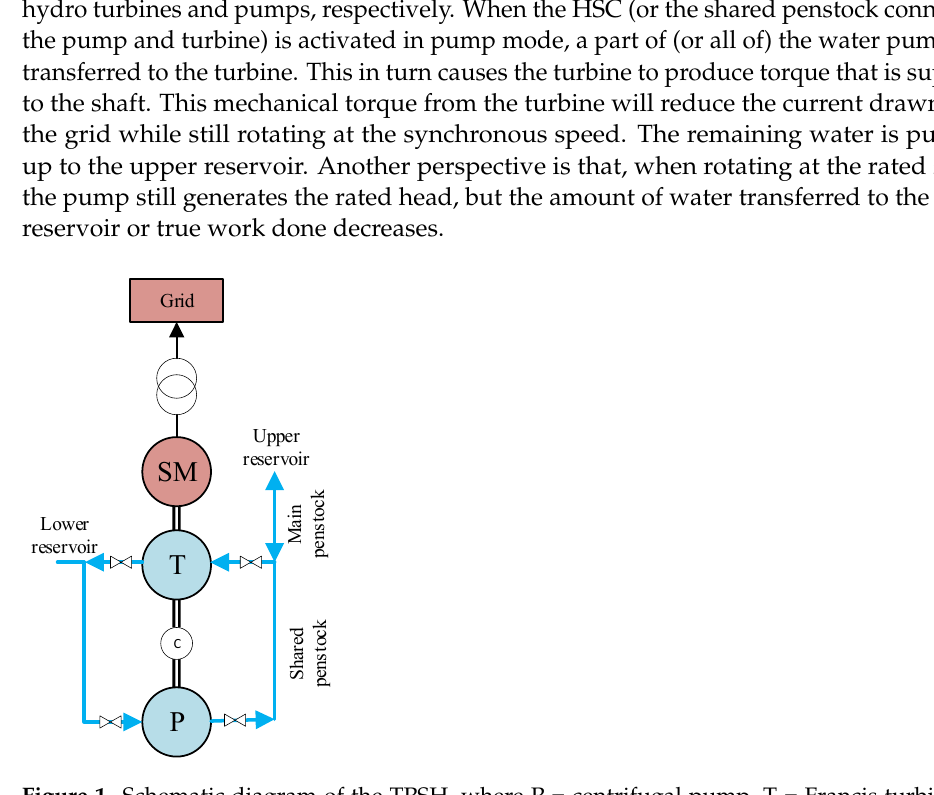
Figure 1. Schematic diagram of the TPSH, where P = centrifugal pump, T = Francis turbine, c = clutch, and SM = synchronous